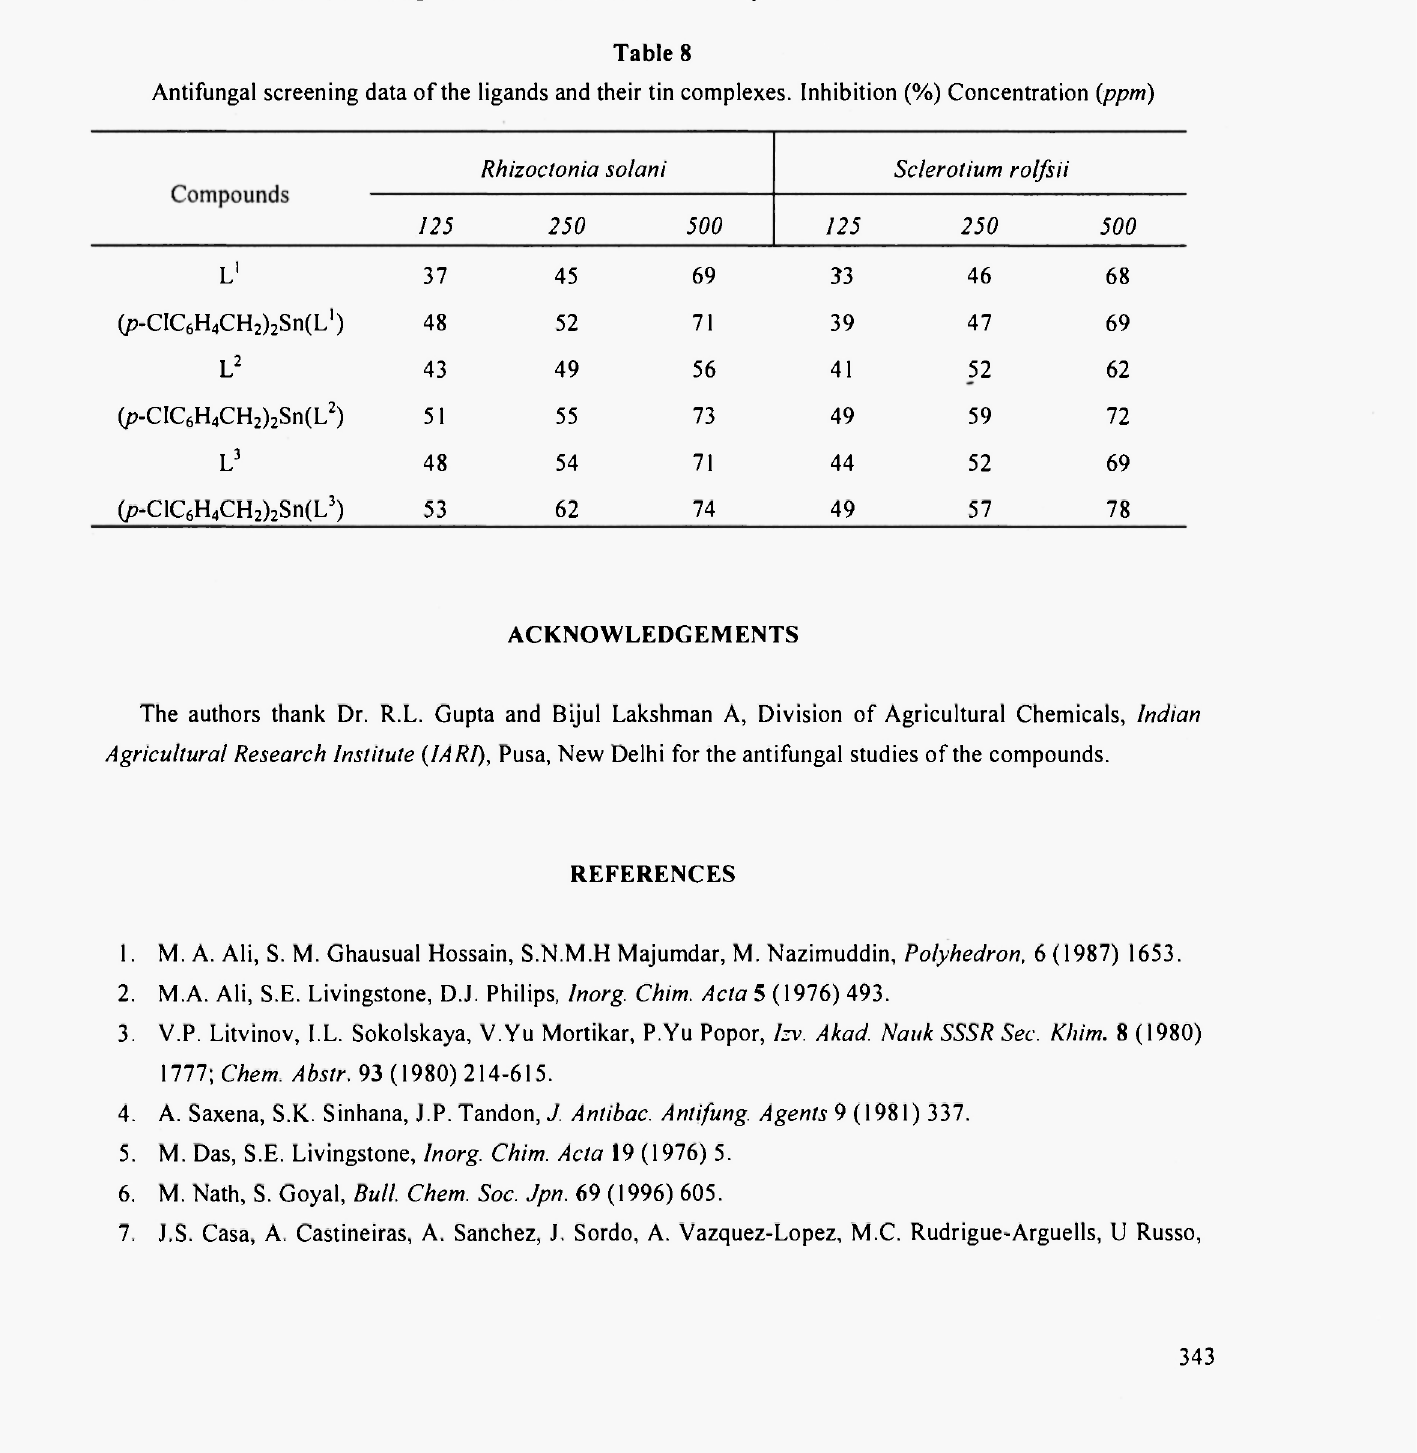
Antifungal screening data of the ligands and their tin complexes. Inhibition (%) Concentration